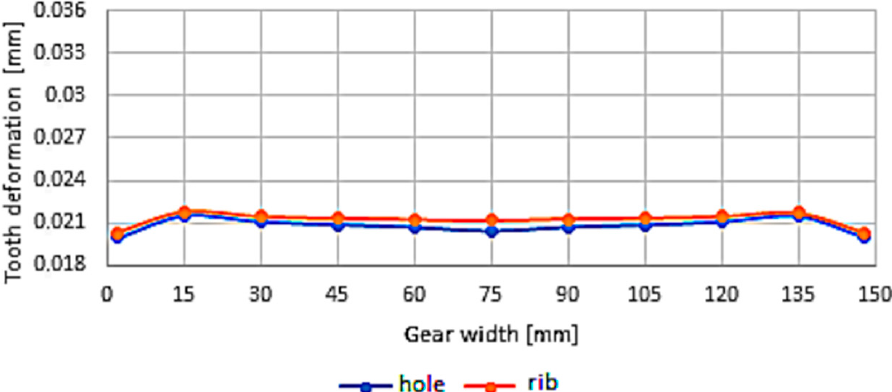
Figure 12. Deformation along the width of the tooth for model B2.